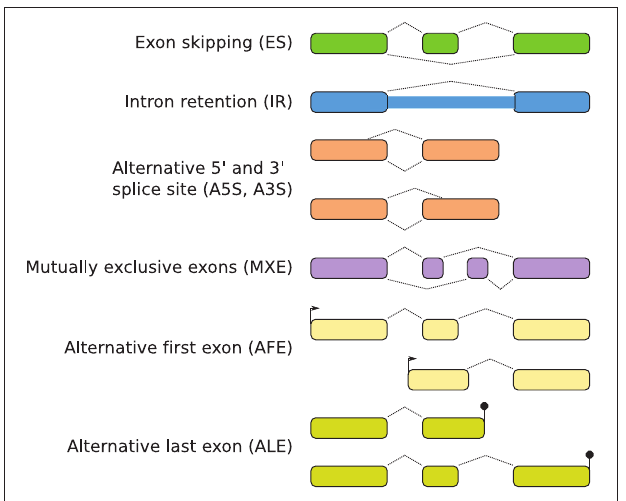
FIGURE 1 | Patterns of alternative splicing (AS) result in different transcript isoforms.